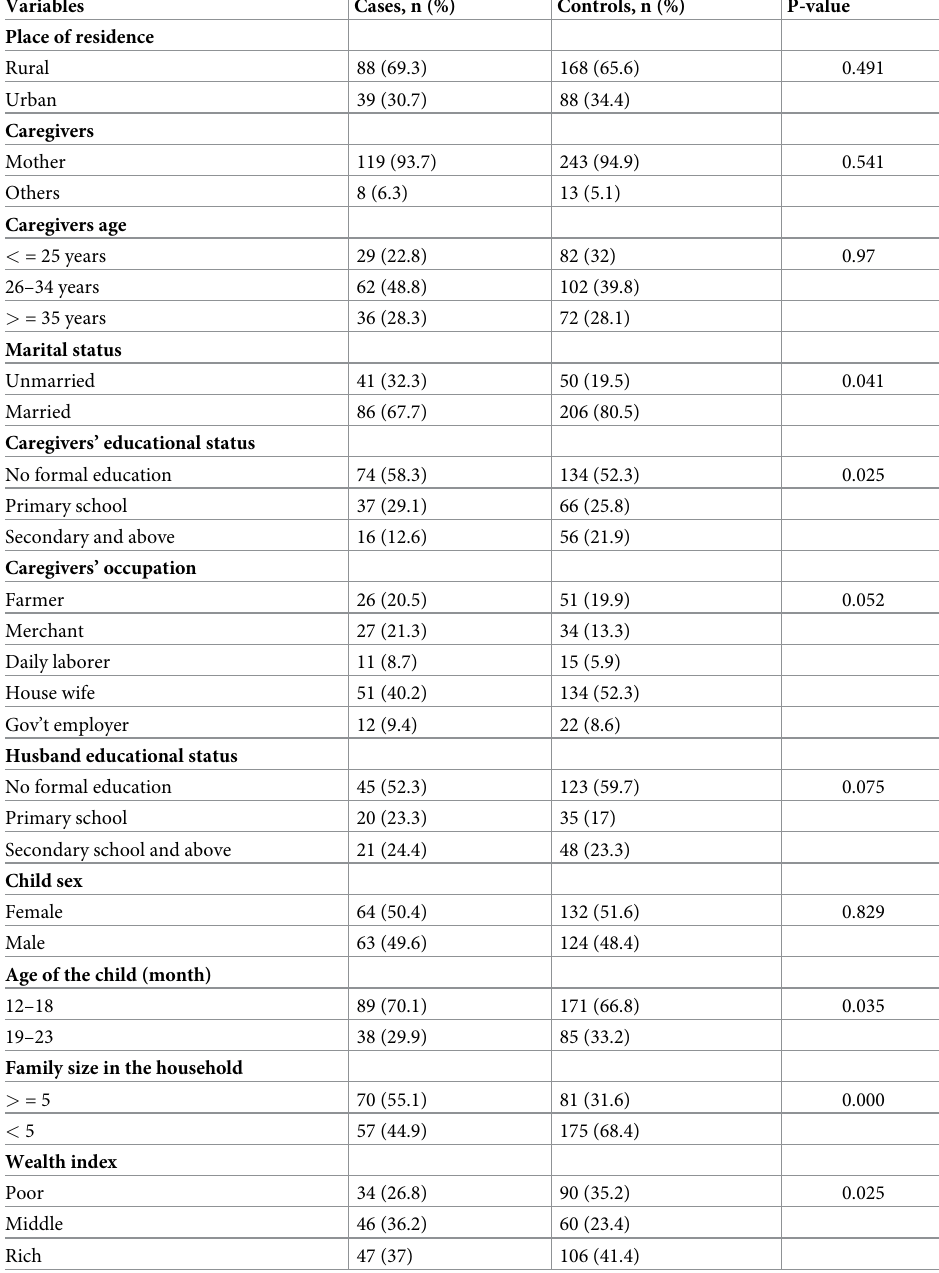
Table 1. Socio-demographic characteristics of caregivers in Dabat district, Northwest, Ethiopia,